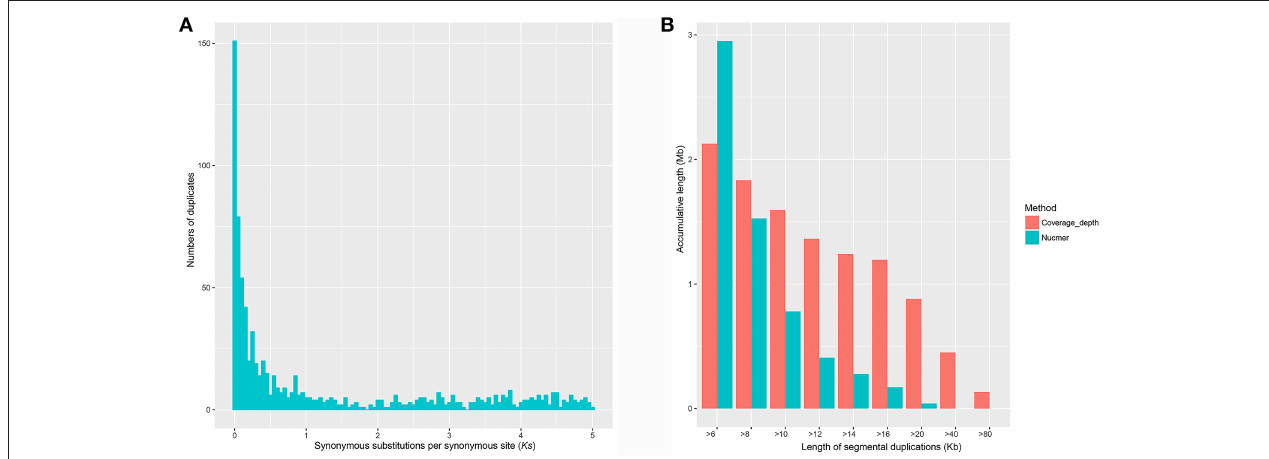
FIGURE 1 | Gene duplications in the S. mansoni genome. (A) Empirical Ks -based age distributions for S. mansoni . The Ks distribution of paralogous genes in the S. mansoni genome is typically L-shaped, which agrees well with the notions that most duplications are young. (B) Segmental duplications identified by Nucmer and coverage-depth methods. Very limited numbers of large segmental duplications were identified.